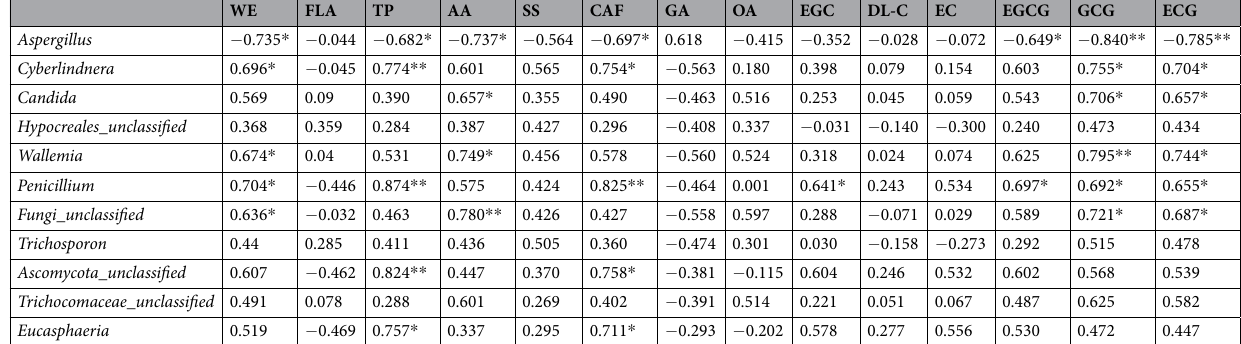
Table 1. Pearson’s correlation between the relative abundances of important genera (relative abundance > 1%) and metabolite variables a . a Water extract (WE), soluble sugar (SS), flavonoid (FLA), organic acid (OA), tea polyphenol (TP), amino acid (AA), gallic acid (GA), caffeine (CAF), epigallocatechin gallate (EGCG), epigallocatechin (EGC), epicatechin gallate (ECG), gallocatechin gallate (GCG), epicatechin (EC), catechins (C). * Indicated that the significance < 0.05; ** indicated that the significance <